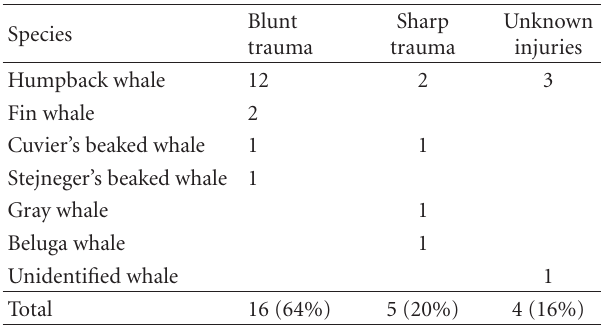
Table 4: Types of injuries sustained by the 25 whales known to have been killed by